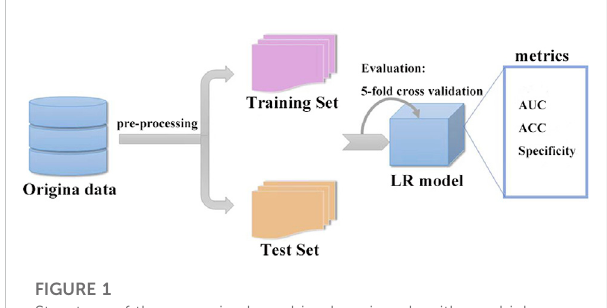
FIGURE 1 Structure of the supervised machine learning algorithm, which can describe this network working principle satisfactorily. The derivation cohort was randomly split into two datasets: a training set (70%) and an internal validation set (30%). After training and validation, wesuccessfullyconstructedalogisticregressionmodel(LR